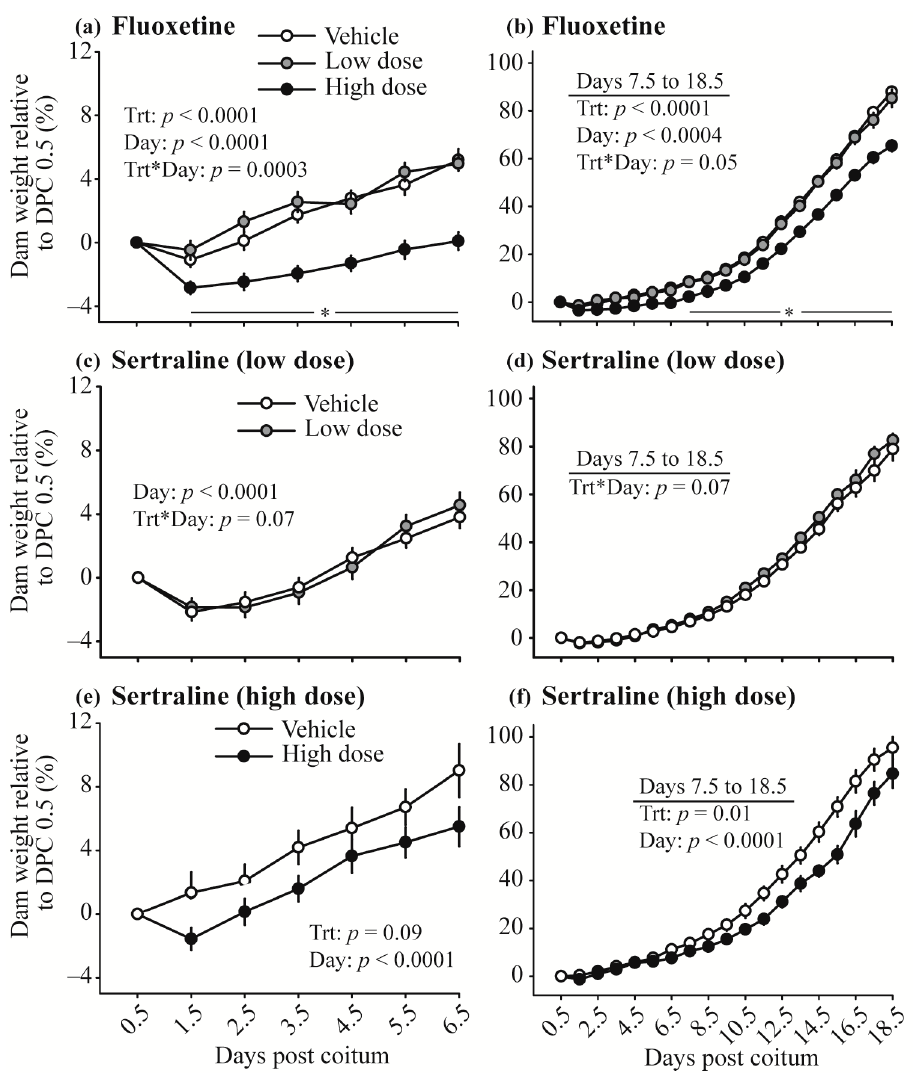
Figure 1. Effect of fluoxetine ( a , b ) and sertraline ( c – f ) on maternal weight gain between days post coitum (DPC) 0.5 to 6.5 ( a , c , e ) using data from pregnant (before the effect of fetal weight on maternal weight), nonpregnant, and virgin mice. Maternal weight gain ( b , d , f ) during entire gestation (DPC 0.5 to 18.5) used data from only pregnant mice with data analyzed for DPC 7.5 to 18.5. * Indicates significantly decreased weight in the high dose of fluoxetine group.